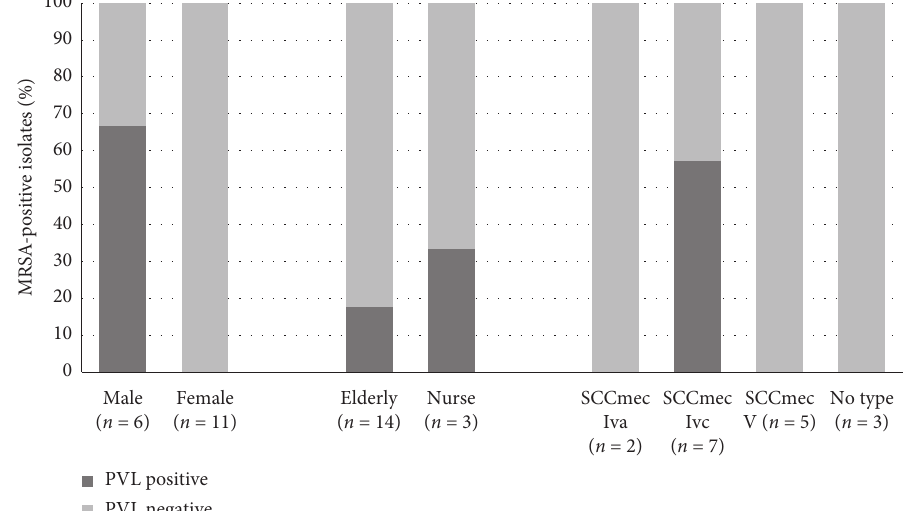
Figure 2: Frequency of methicillin-resistant Staphylococcus aureus (MRSA) colonization in positive and negative PVL isolates. Four male samples were positive for PVL (66.67% (4/6)). Three (21.43% (3/14)) were elderly and one (33.33% (1/3)) was a nurse. The 4 PVL-positive isolates were all SCC mec -IVc (57.14%